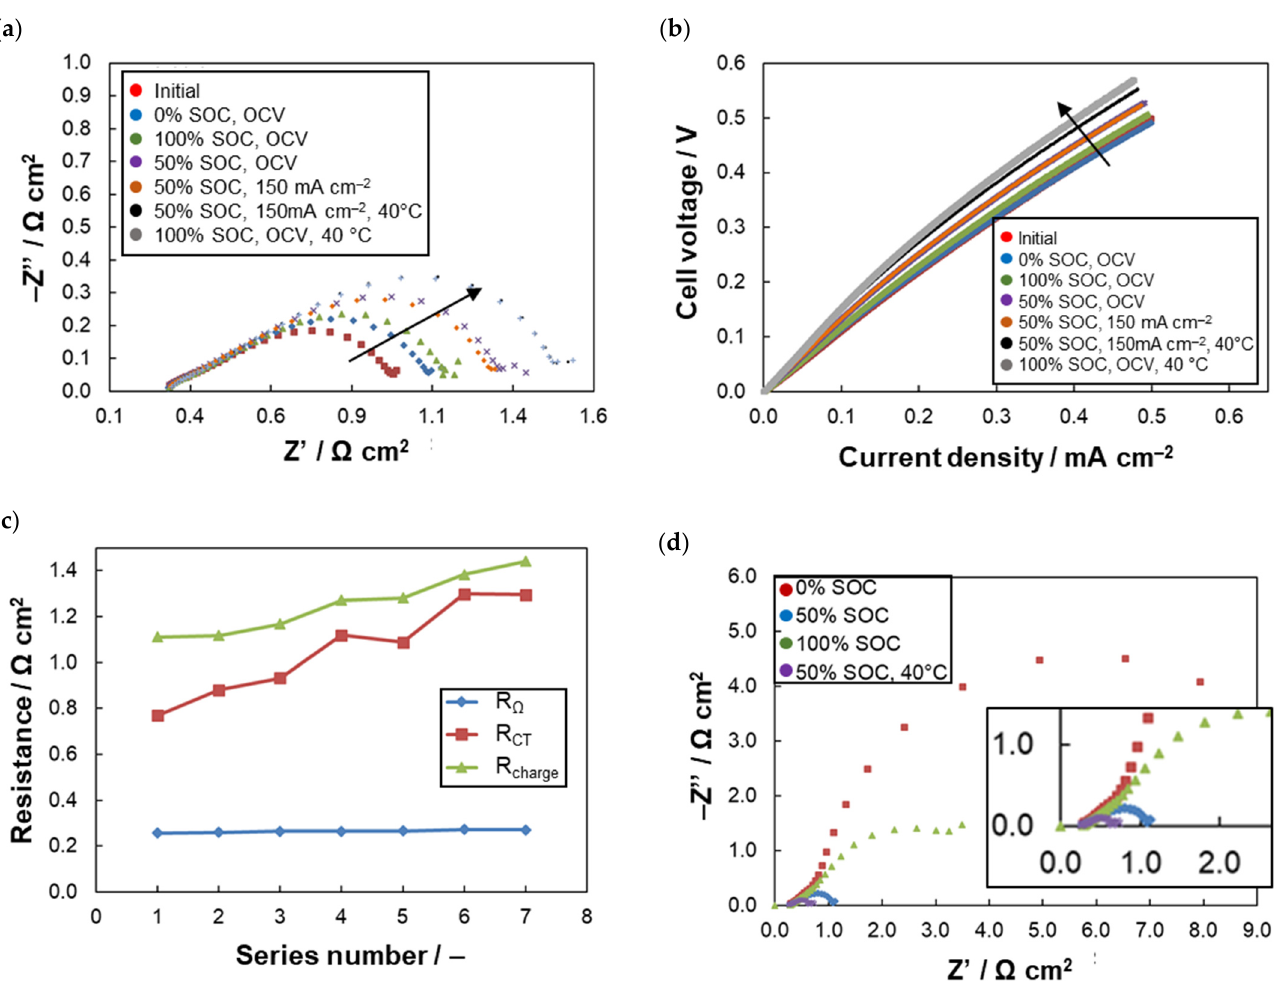
Figure 5. EIS spectra ( a ) and load curves ( b ) of DHC in 50% SoC after individual holds and development of evaluated resistances during experiment ( c ); EIS Nyquist spectra in different electrolyte SoC and temperatures ( d ).